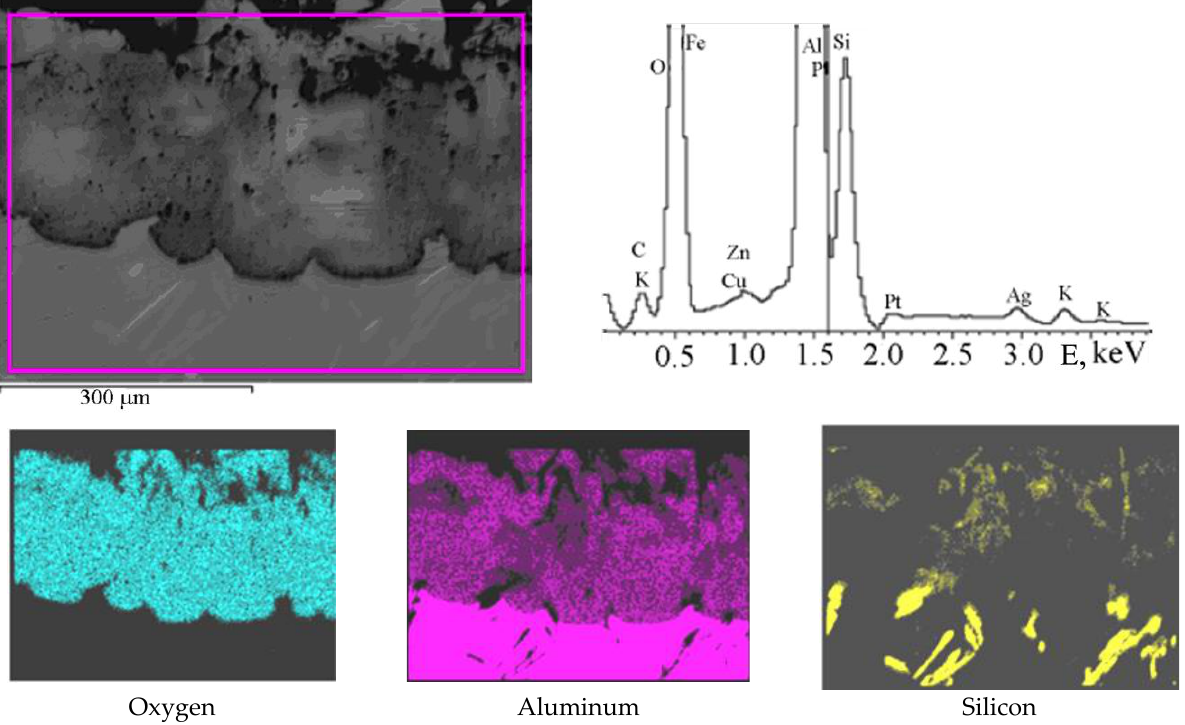
Figure 9. Distribution of oxygen, aluminum and silicon over the cross-sectional area of the PEO layer on the AK9 alloy synthesized in 3 g/L KOH + 2 g/L Na 2 SiO 3 electrolyte.